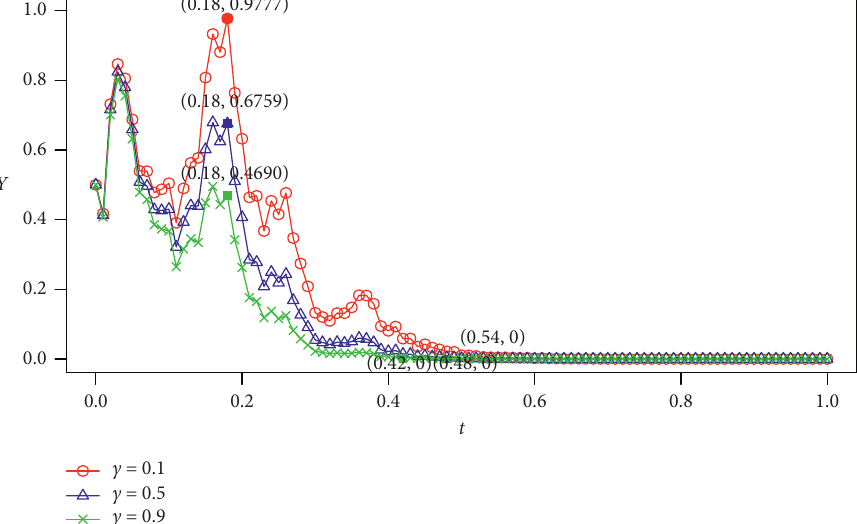
Figure 4: The impact of the degree of financial subsidies c on commercial bank’s strategy